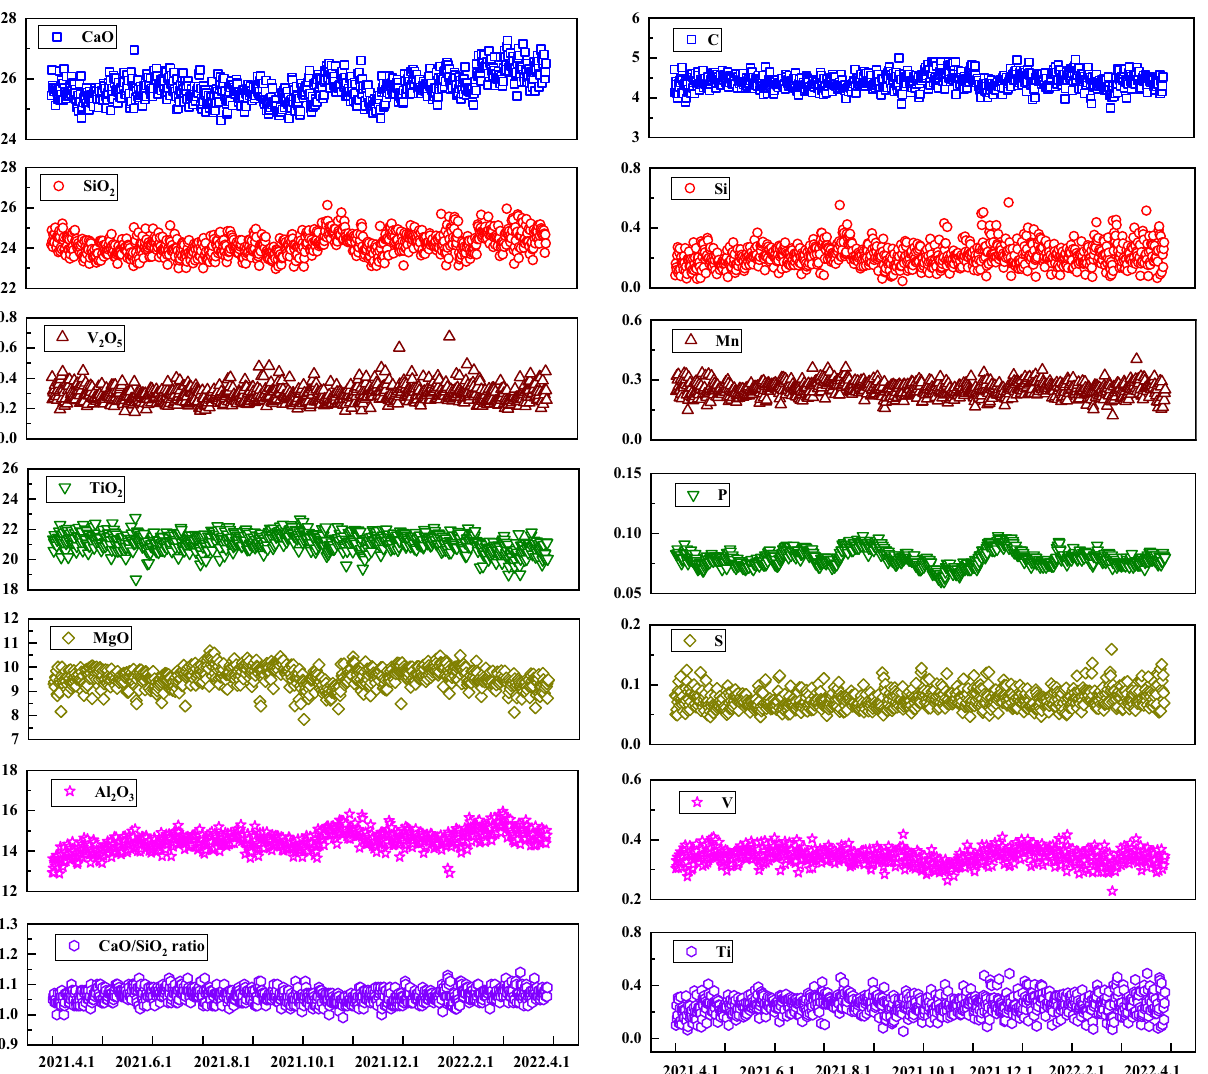
Figure 3: Composition ( wt% ) of slag produced in the VTM smelting BF over the 1 year ( 2021 – 2022 ) .